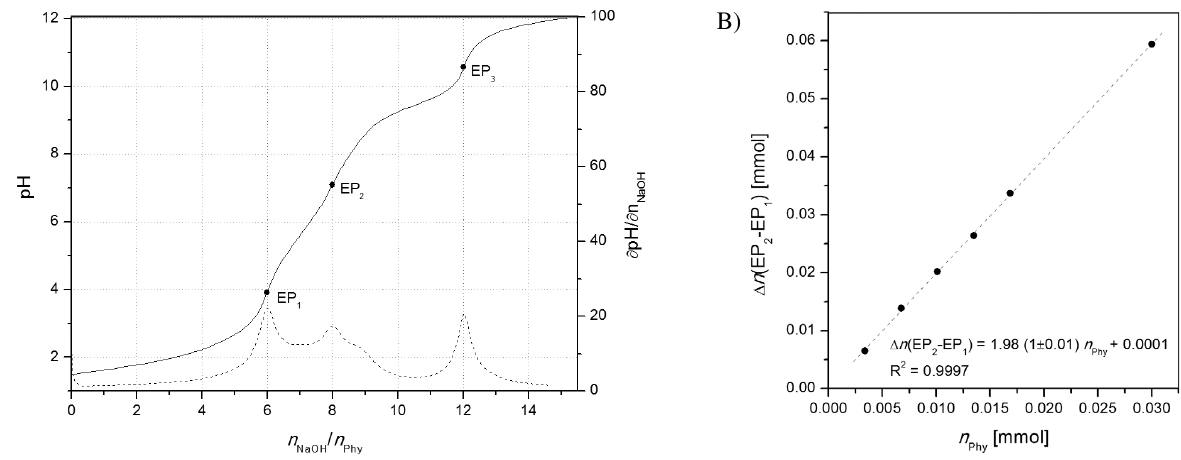
Figure 4. (A) Titration of 0.3081 mmol H Phy in 1.0 M NaCl with 0.0996 M NaOH. Equivalents of NaOH per mole of phytate are given on x-axis. 12 Dashed line represents the corresponding derivative ∂ pH/ ∂